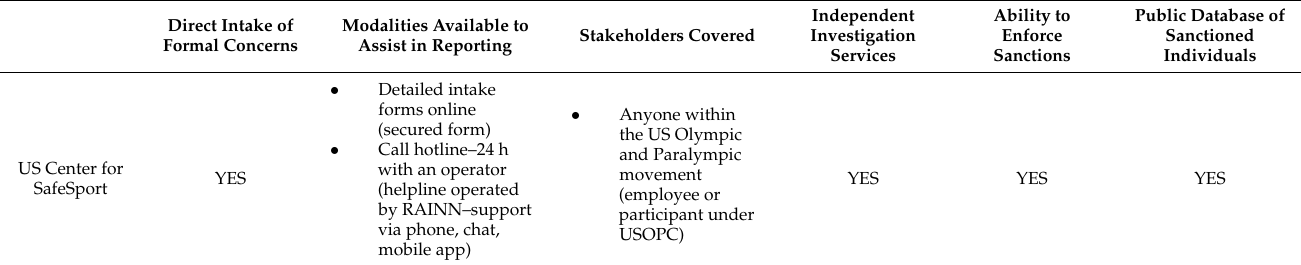
Table A3. General Structure, Accessibility, and Capacity of Reporting